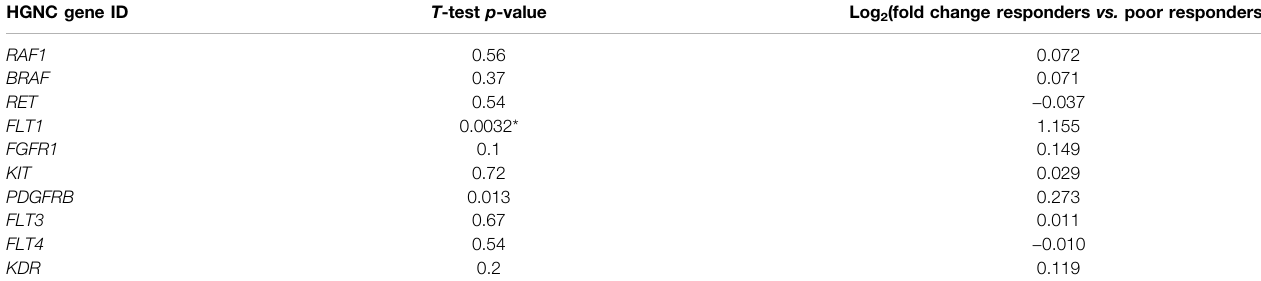
TABLE 5 | Differential expression analysis of sorafenib responders ( n = 12) and poor responders ( n = 10) in microarray-pro fi led RCC samples